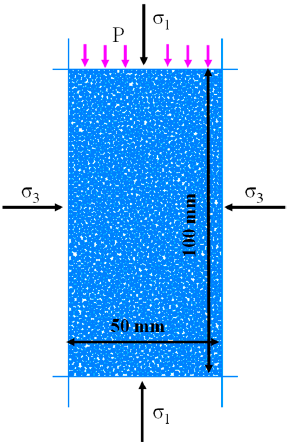
Figure 8. Model, initial conditions and boundary conditions.